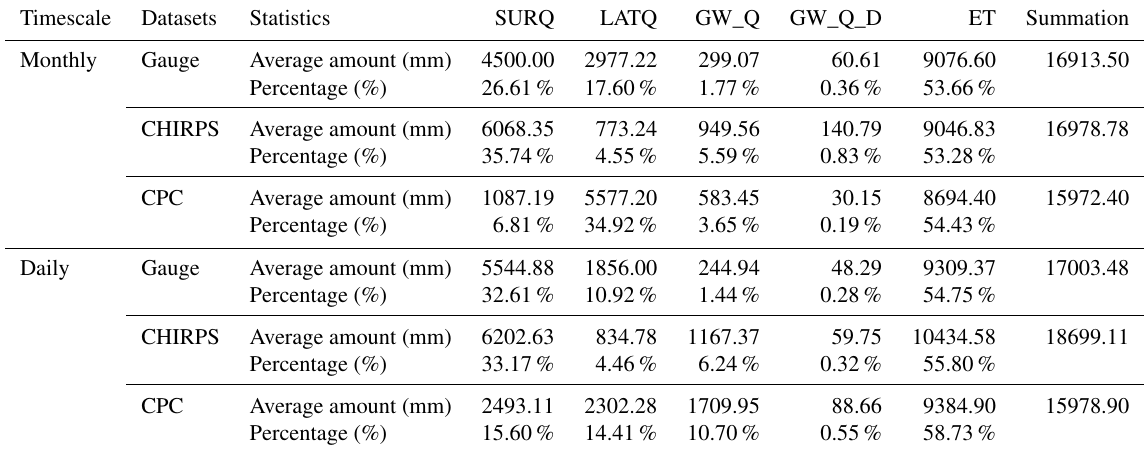
Table 5. Summarization of water balance components of the three models for the whole JRW.